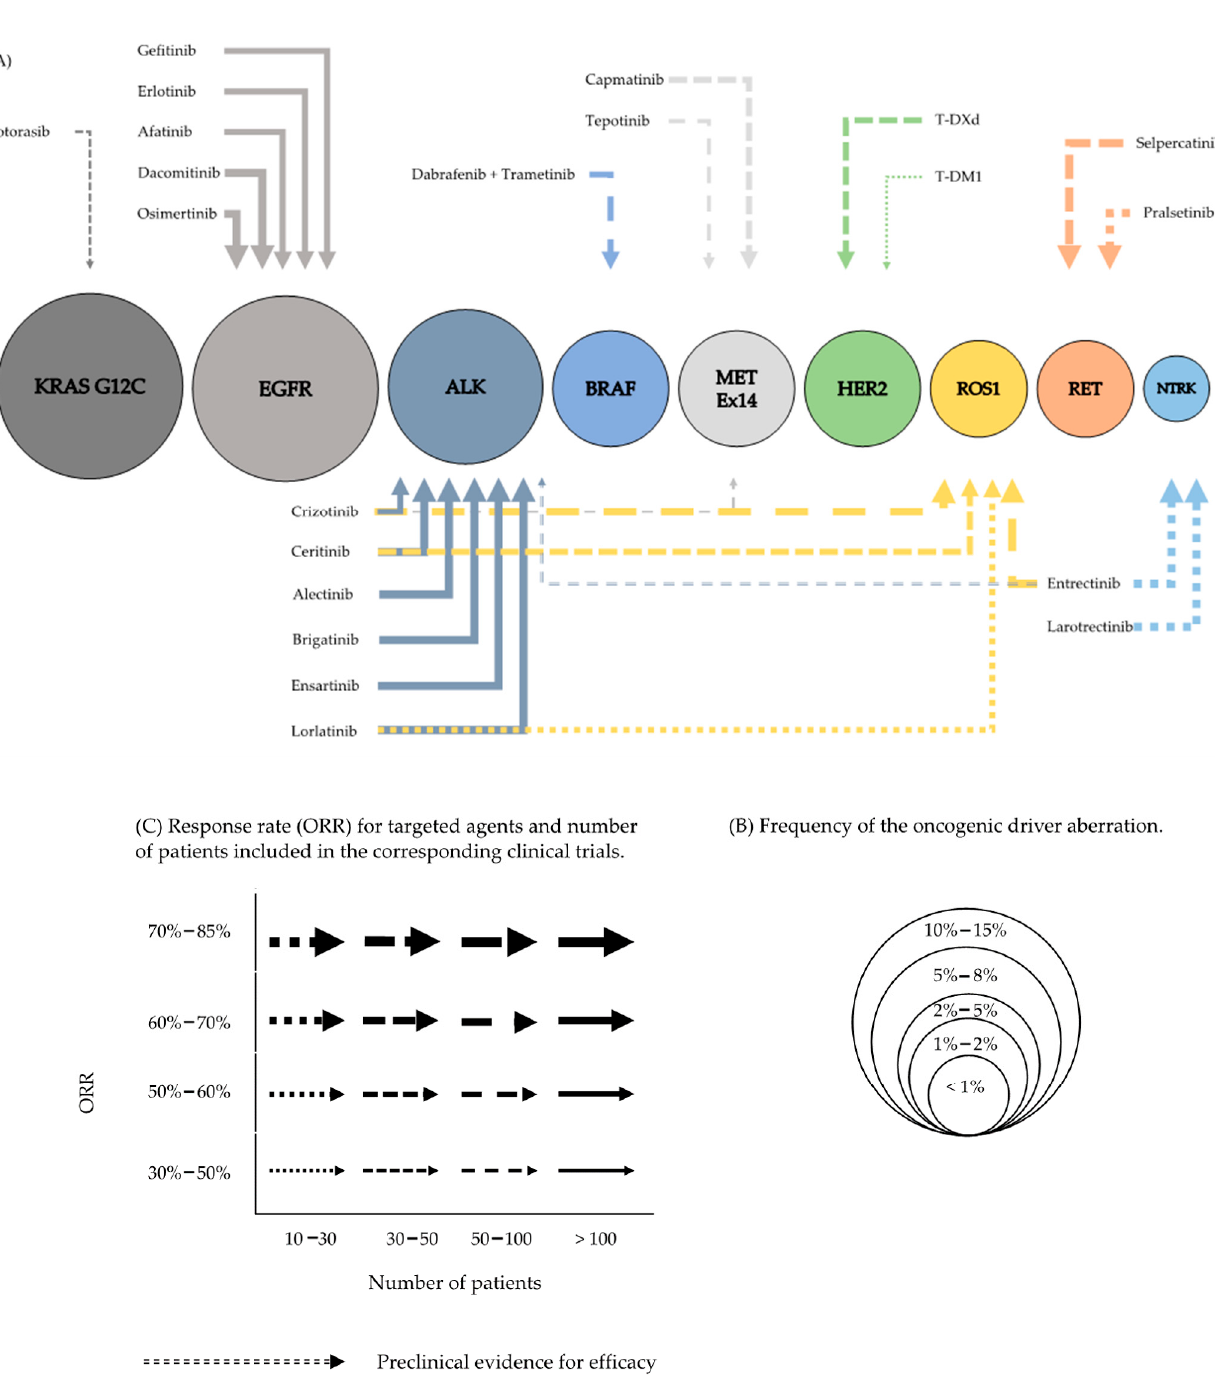
Figure 1. Molecular oncogenic driver aberrations and targeted therapies. Graphic overview ( A ). The size of the circles indicates the frequencies of the oncogenic driver aberration ( B ). The arrow thickness reflects the magnitude of response (ORR) for every targeted agent and the style of the line (continuous, dashed, dotted) the number of patients included in the corresponding clinical trials ( C ).